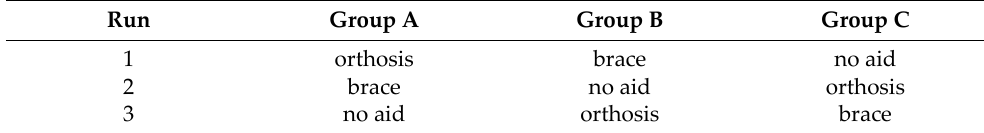
Table 1. Individual group test